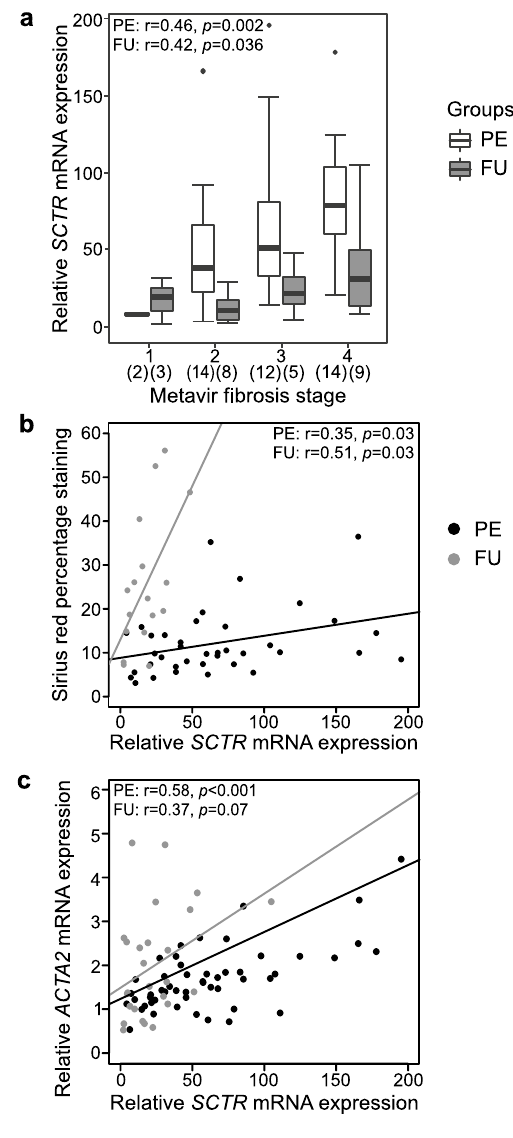
Figure 3. Correlations between liver secretin receptor ( SCTR ) mRNA expression and surrogates for liver fibrosis. ( a ) Box plot (median, interquartile range and 90th percentile) of relative SCTR expression in biliary atresia patients at portoenterostomy (PE) and during follow-up (FU) according to Metavir fibrosis stages. Correlation between SCTR and ( b ) Sirius red percentage staining and ( c ) ACTA mRNA expression. Black dots represent samples obtained at PE and grey dots represent follow-up (FU) samples after successful